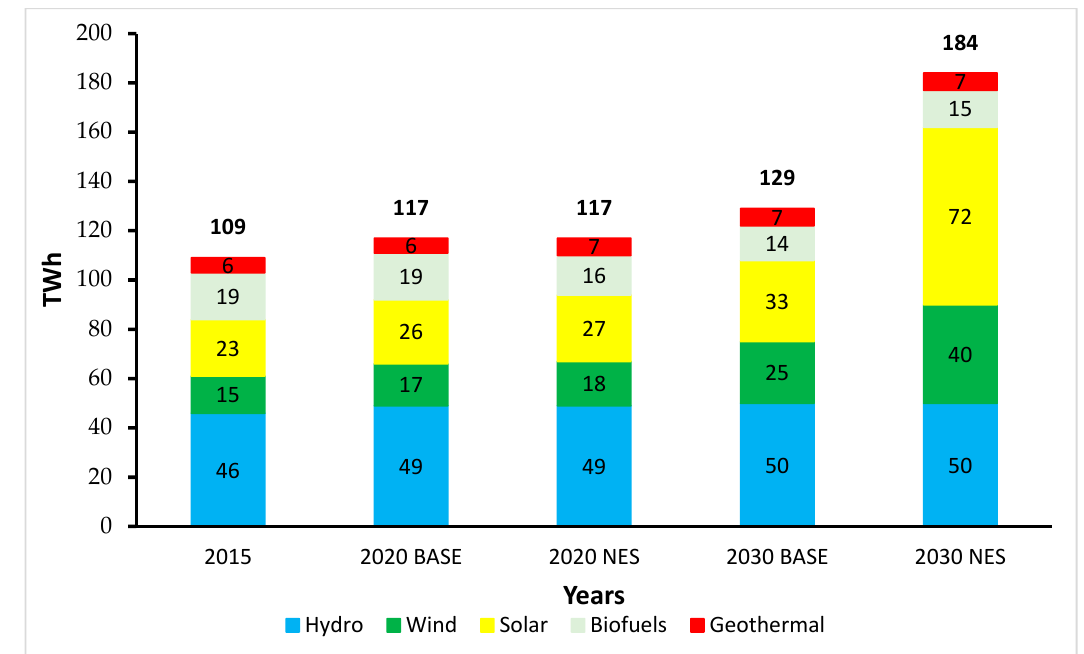
Figure 5. Evolution of Italian RES generation in the baseline scenario (based on pre-2014 policies) and the NES/NECP scenario (TWh) [18].